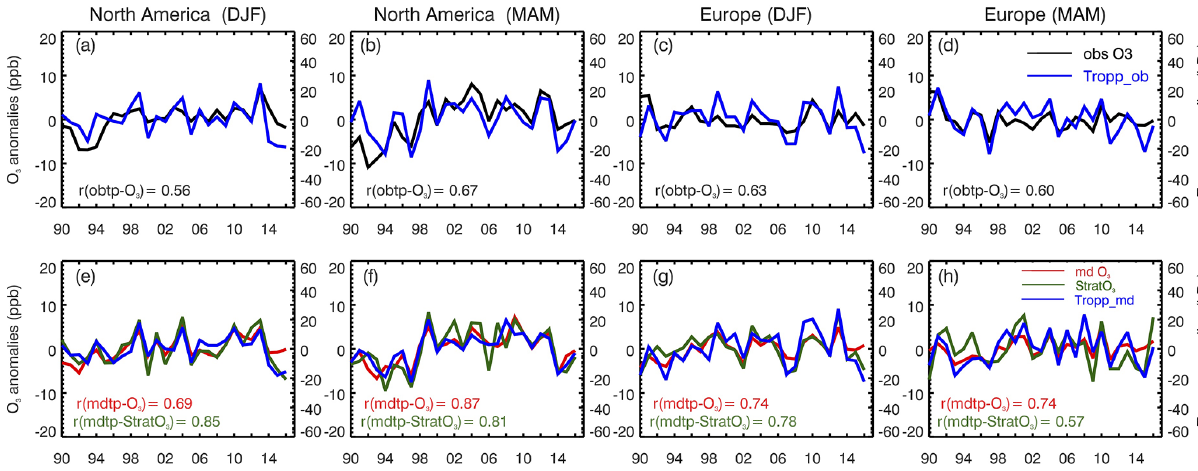
Figure 4. (a–d) Time series of the observed ozone mixing ratio anomalies at 400hPa and the tropopause pressures derived from observed ozone profiles averaged over the North American and European sites in winter and spring. Their correlation coefficients are shown in black text. (e–h) Time series of the simulated ozone and StratO 3 anomalies at 400hPa with the tropopause pressures derived from simulated ozone profiles, with the respective correlation coefficients shown in red and green